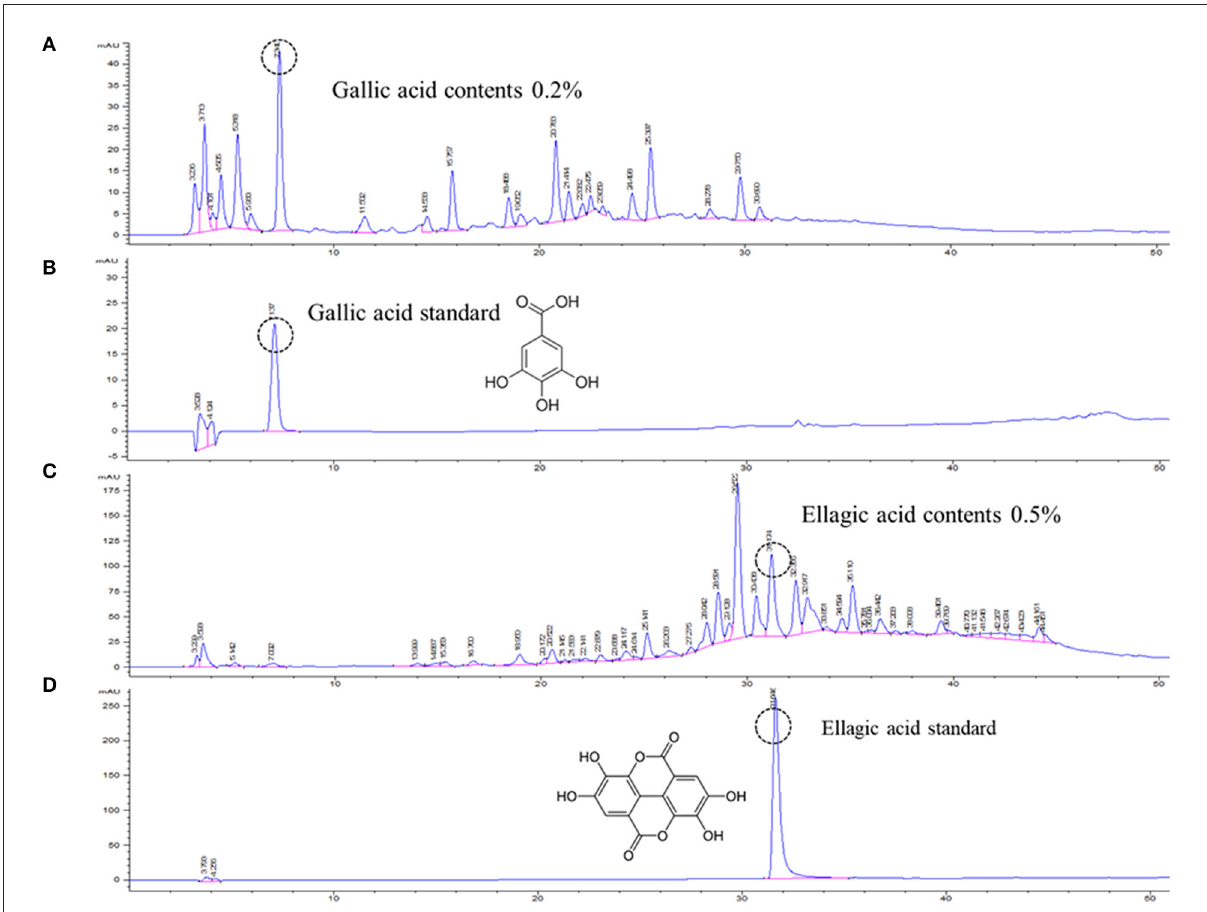
FIGURE1 Representative chromatogram of CISE. Water fraction (CISE-DW, A ) and ethanol fraction (CISE-ET, C ) of CISE and the standard marker compounds gallic acid (B) and ellagic acid (D) .